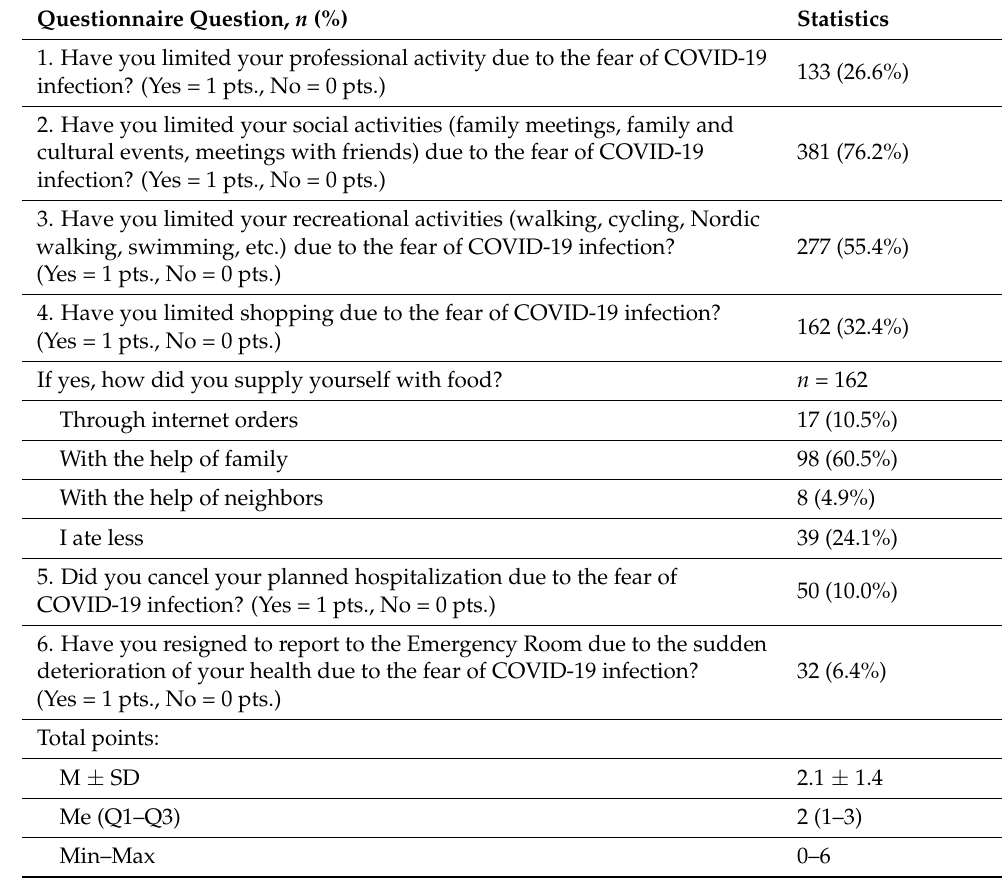
Table 2. Assessment of the behavior during the COVID-19